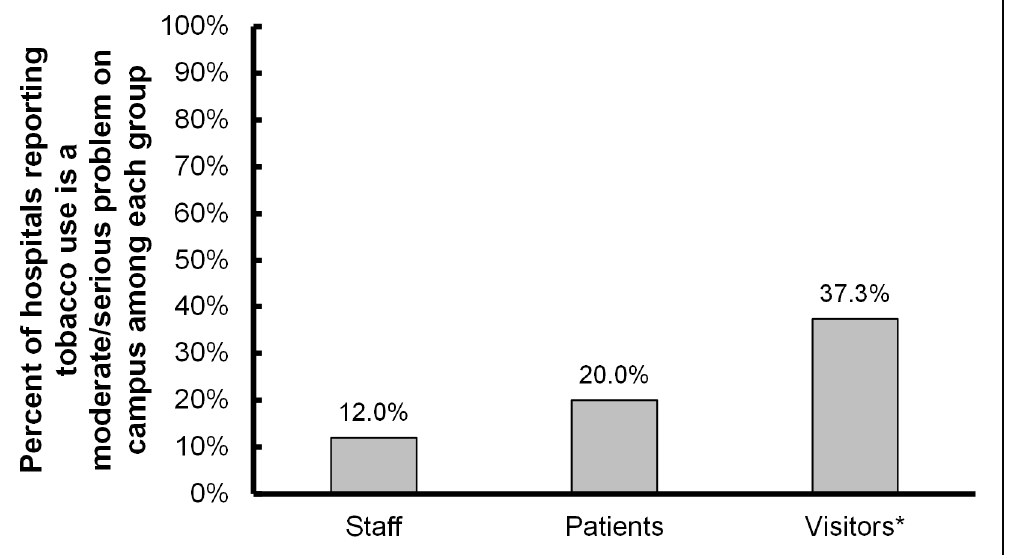
Figure 2. Use of tobacco products currently a problem on the hospital campus ( n = 75). * Significantly different compared to staff ( p < 0.01) and patients ( p = 0.02).